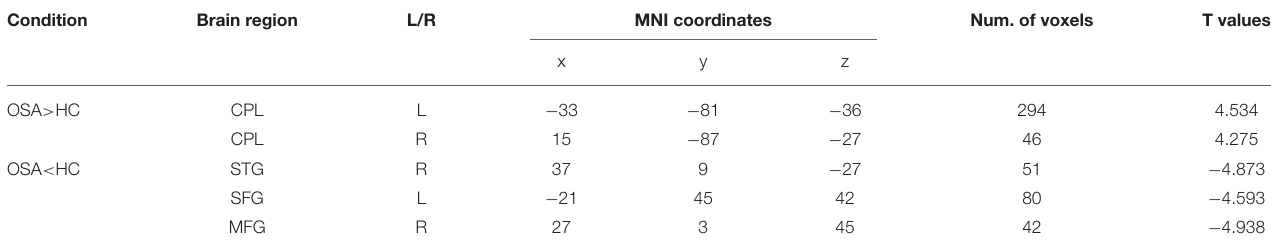
TABLE 2 | Brain areas showed significant differences in DC between pre-CPAP OSA patients and HCs (r 0 = 0.25). Condition